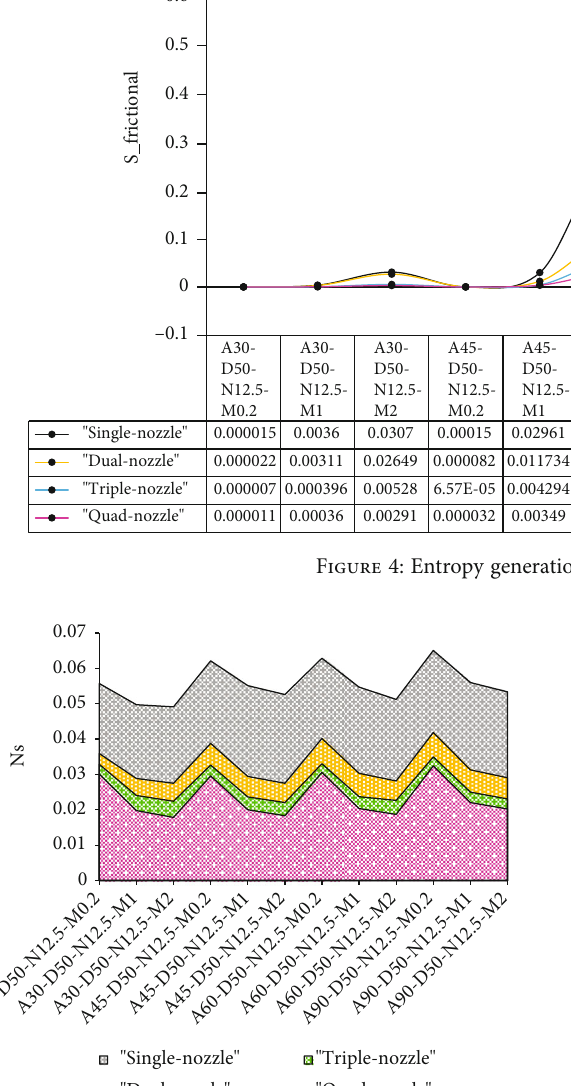
Figure 5: Dimensionless entropy